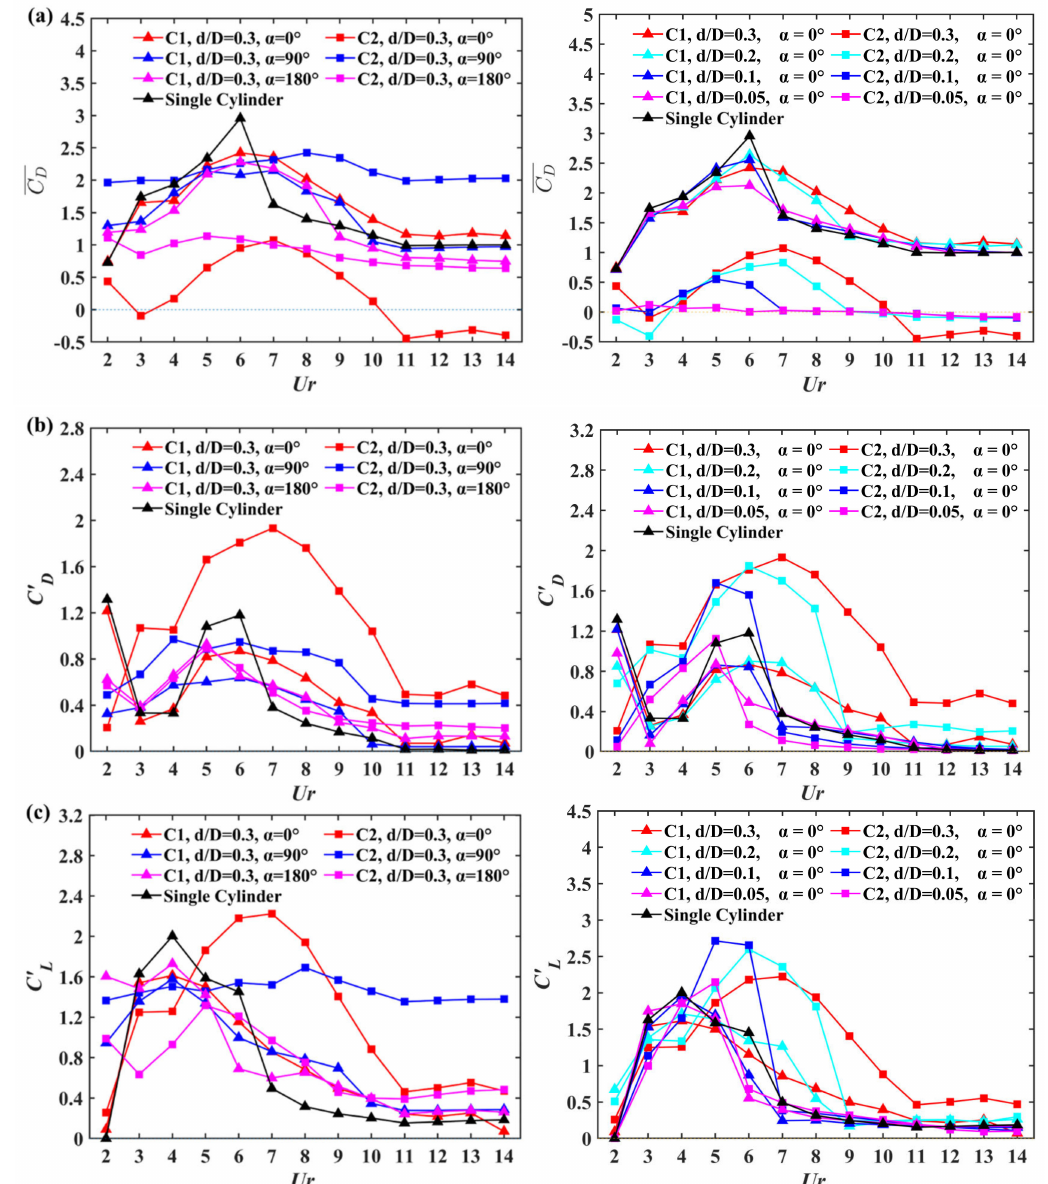
Figure 5. Variations in the force coefficient with the reduced velocity: ( a ) the mean drag coefficient; ( b ) the r.m.s. drag coefficient; ( c ) the r.m.s. lift